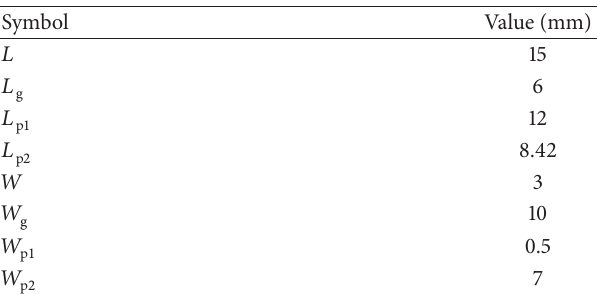
Table 1: Dimensions of the proposed